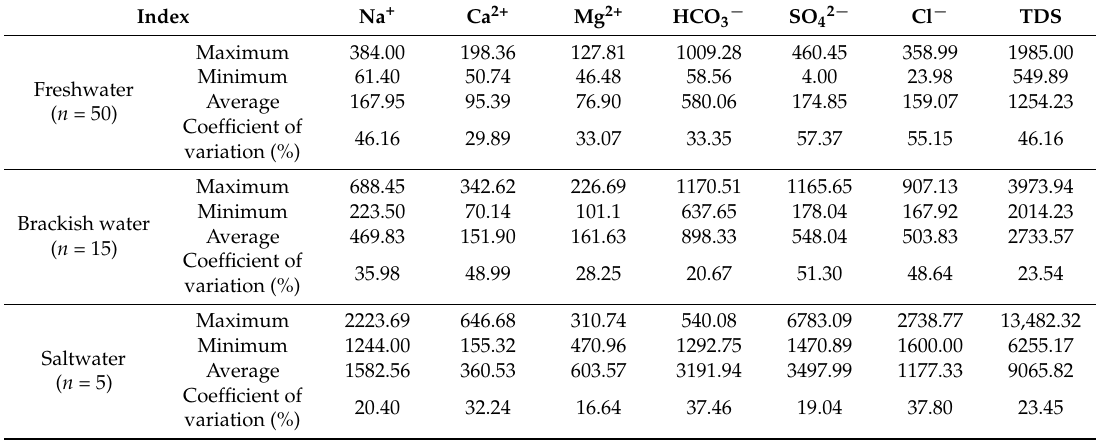
Table 2. Unconfined common water chemical composition characteristic value ( n =